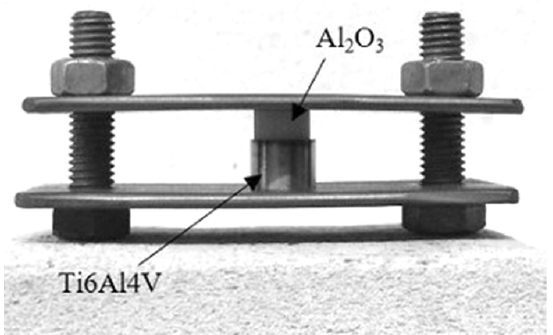
Figure 1. Device used to apply the contact pressure at the faying surfaces during the diffusion bonding experiments.